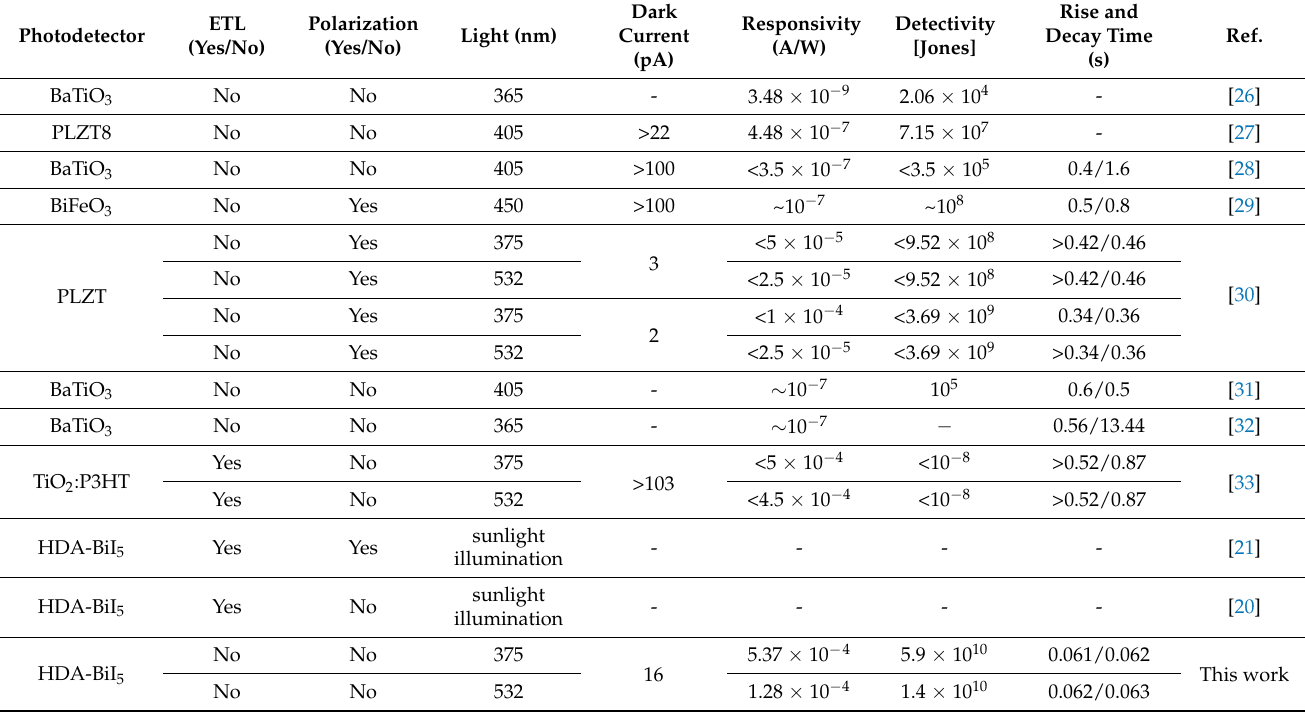
Table 1. Comparison of HDA-BiI 5 - based photodetector with other similarly structured materials devices. Photodetector